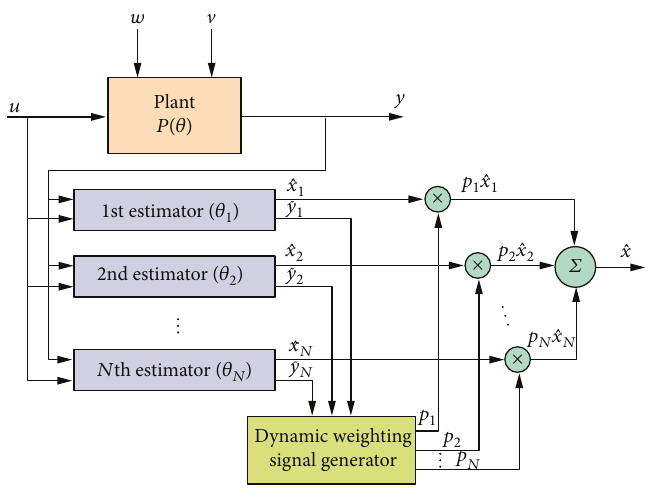
Figure 1: The block diagram of an MMAE